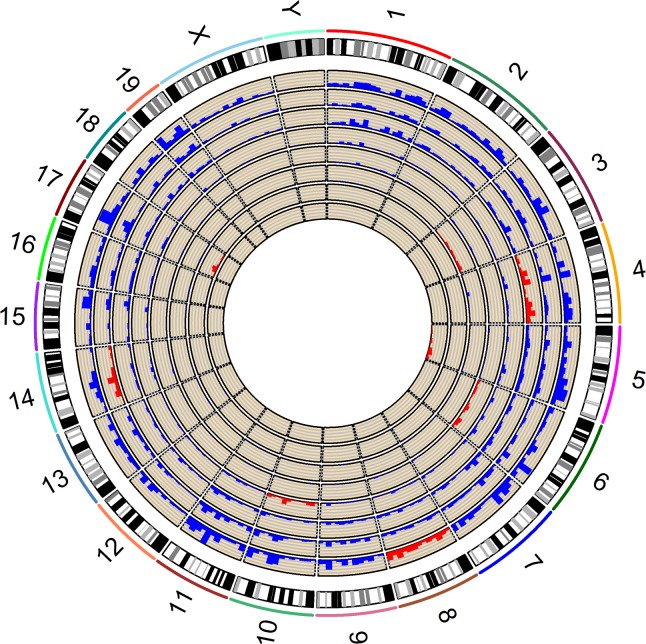
Identification of meQTLs that regulate hepatic gene expression.A circos plot of meQTL locations in the genome where each layer of the circle represents the comparison between a CSS strain and control B6 mice. From the inner circle, the CSS strains are (B6 x B6.A5)F1, (B6.17 x B6)F1, (B6.A3 x B6)F1, (B6.A6 x B6)F1, (B6 x B6.A10)F1, (B6 x B6.A4)F1, (B6.A14 x B6)F1 and (B6 x B6.A8)F1. Cis-meQTLs and trans-meQTLs are marked with red and blue, respectively. The width of each chromosome is proportional to its physical size. The height of each meQTL bar is proportional to the number of meQTLs in that genomic interval.